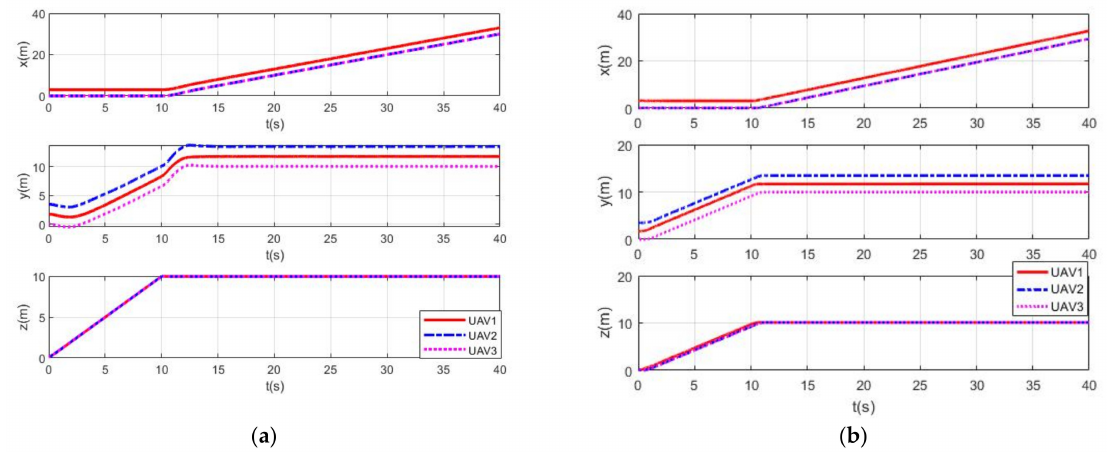
Figure 6. States of the TS for UAVs with SMC ( a ) and MPC ( b ).